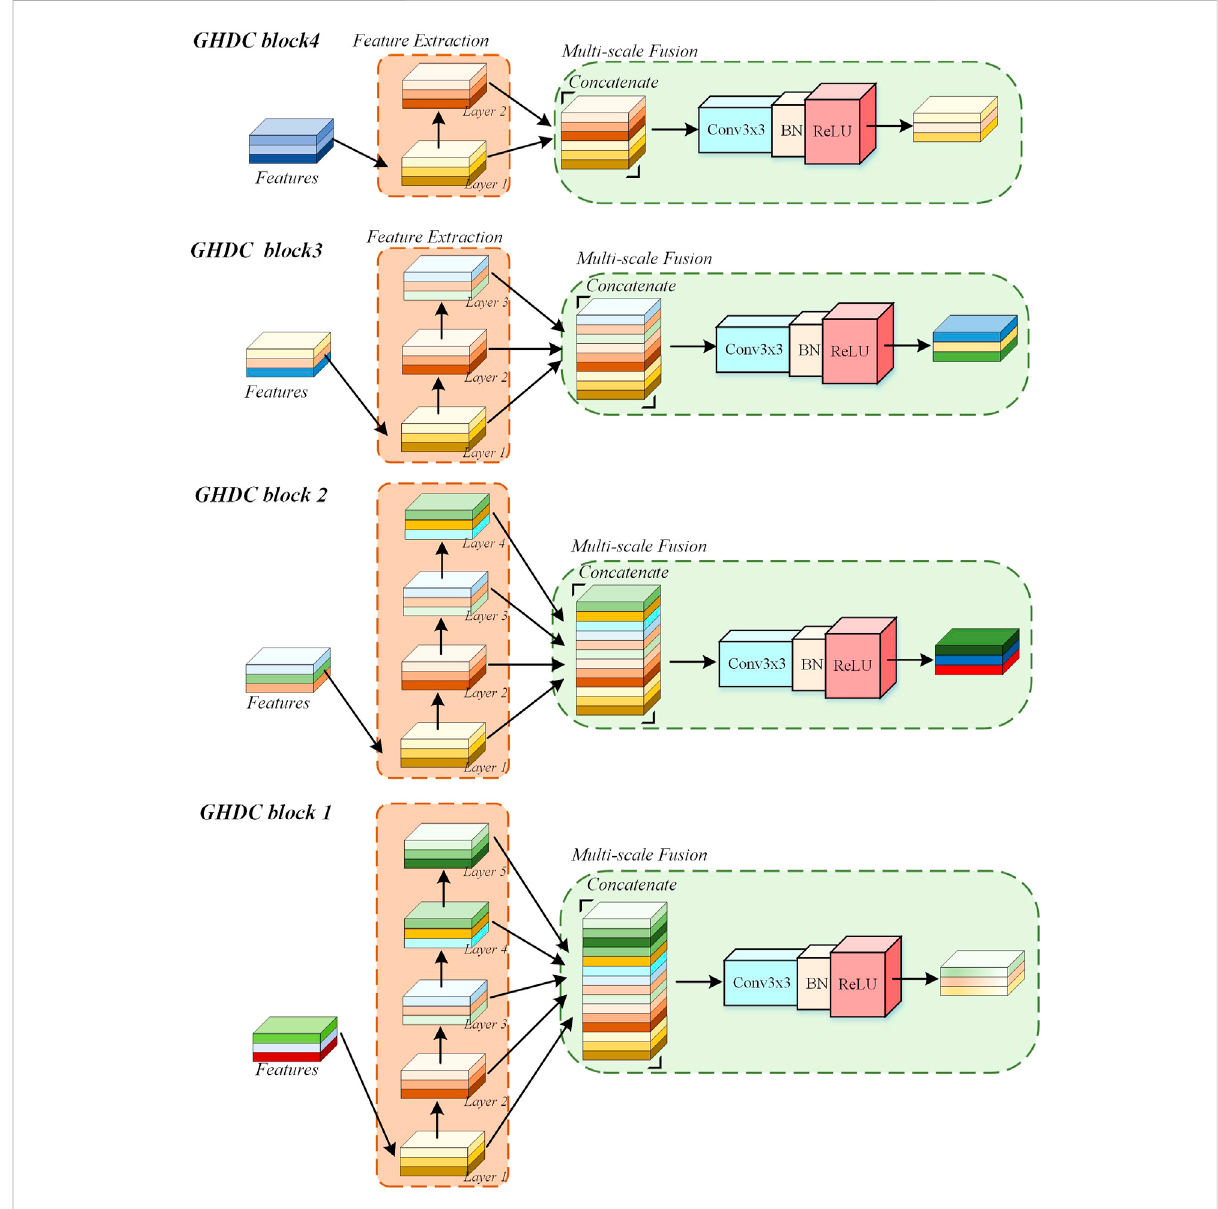
FIGURE 5 The detailed structure of the GHDC